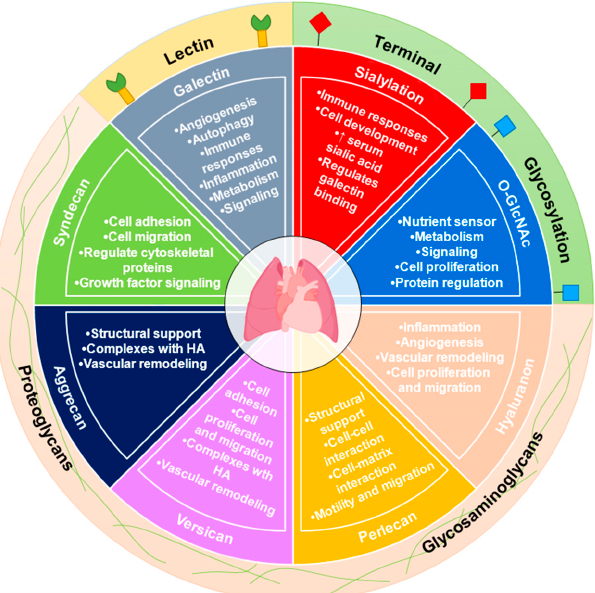
Figure 1. The glycobiology of PAH. Changes in glycosylation have been linked to dysregulated cellular metabolism, a hallmark of both PAH and cancer. Galectins (Lectins); O-GlcNAc and sialylation (Terminal Glycosylation); as well as hyaluronan, perlecan, versican, aggrecan, and syndecan (Proteoglycans and Glycosaminoglycans) have been investigated in PAH. PGs/GAGs (HA) and galectins are increased in PAH. In addition, sialylation may be altered. However, there specific roles and how they contribute to vascular remodeling and regulation of vascular function as well as cell proliferation, cell signaling, and cell differ- entiation/morphology have not been defined. Are the changes observed in these gly- cans/glycoconjugates a consequence of the metabolic derangements observed in PAH? Or do these glycoconjugates, when altered, have a direct role in the PAH pathogenesis? Stud- ying the specific role of glycans and/or glycoconjugates is critical to fully understanding the molecular mechanisms associated with dysregulated metabolism in PAH. These ef- forts cannot move forward without some technical challenges, which are contingent on the availability and accessibility of better tools for quantifying and precisely determining the roles of glycans and glycosylation events in cell biology. Targeted approaches to reg- ulating glycosyltransferases/hydrolases, sugar nucleotides, and/or specific glycoconju- gates/glycoforms are needed to advance our knowledge of pulmonary hypertension as well as other diseases defined by metabolic dysregulation. Author Contributions: Conceptualization, J.W.B. and S.K.; writing—original draft preparation, S.V., P.C., S.K. and J.W.B.; writing—review and editing, S.V., P.C., J.S.D., S.K. and J.W.B. All authors have read and agreed to the published version of the manuscript. Funding: This work was supported by the National Institutes of Health (R01HL152246 to J.W.B. and R01HL160911 to S.K.) Conflicts of Interest: The authors declare no conflict of interest.